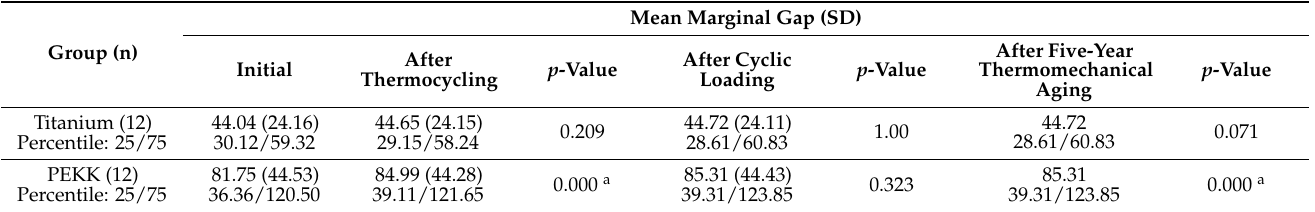
Table 1. Mean ( µ m) values of vertical marginal gap of three-unit FPDs initially, after different aging conditions and a five-year